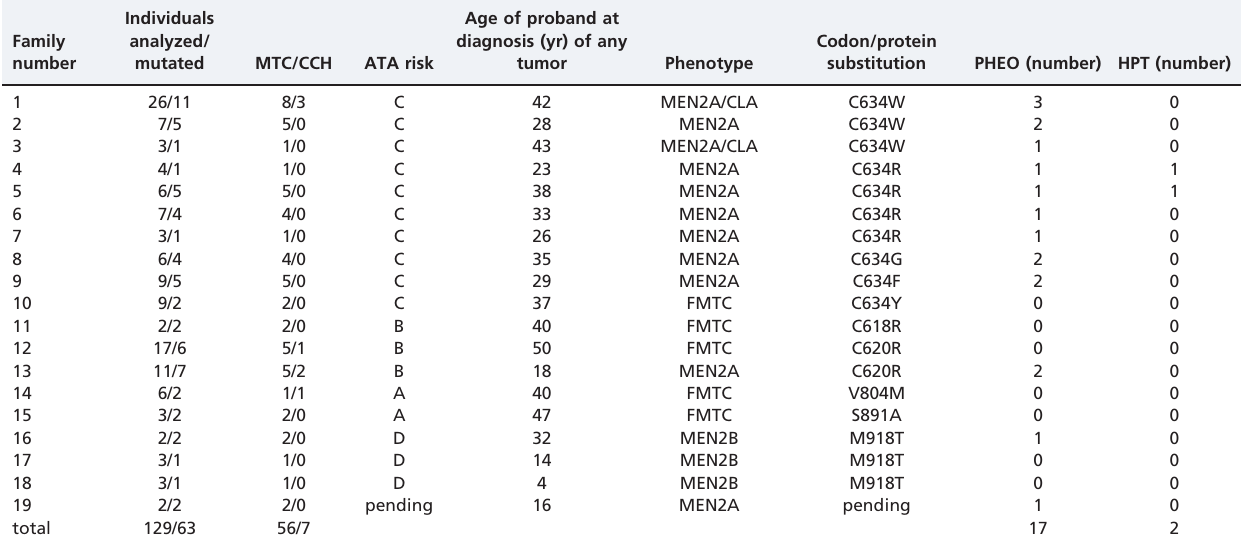
Table 5 - Clinical characteristics and RET mutations in families with MEN2. Individuals Family analyzed/ number